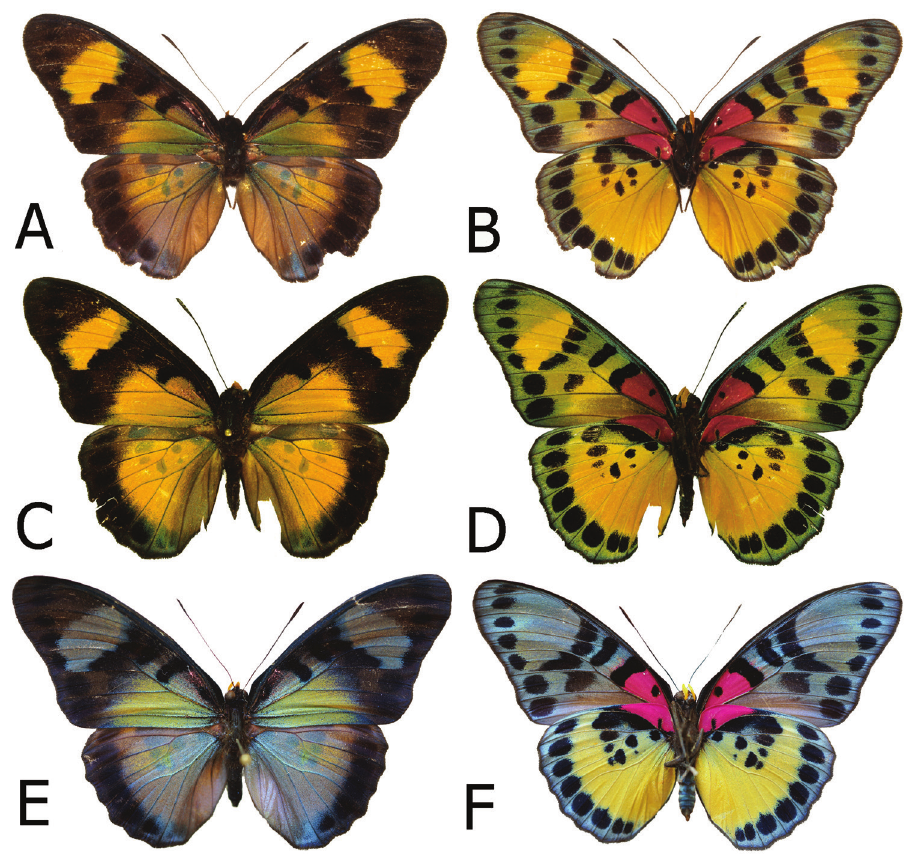
Figure 7. Adults, females: A E. sarcoptera sarcoptera Nsukka, Nigeria (dorsum) B E. sarcoptera sarcoptera Nsukka, Nigeria (venter) C E. sarcoptera ferrea Mont Nimba, Guinea, paratype (dorsum) D E. sarcoptera ferrea Mont Nimba, Guinea, paratype (venter) e E. sarcoptera styx Tai, Ivory Coast (dorsum) F E. sar- coptera styx Tai, Ivory Coast apex dusted with dark blue; a golden yellow area from wing base to two-thirds of anal margin, covering lower half of discal cell; a prominent mid discal cell black round spot; a large, elongated golden yellow subapical patch, extending widely from subcosta costa to vein Cu1, with an irregular basal limit marked by an incision along vein M3, and a diffused outer limit, not reaching outer margin; fringes grey and black. HWD subtriangular with a gently scalloped outer margin; golden yellow, from Rs to costal margin dull brown; submarginal and marginal area black with a strong blue sheen, gradually narrowing from costa, where some 4 mm wide, to tornus, where blue takes over black; fringes grey and black. FWV green yellow, except for basal one-third where free of green and in subapical area where forming a large, diffuse patch; basal to median area purple; a series of black patches, a small rounded postbasal spot, a wide mid cell bar, a similar bar along discal cell distal margin, four patches along basal limit of a dif-